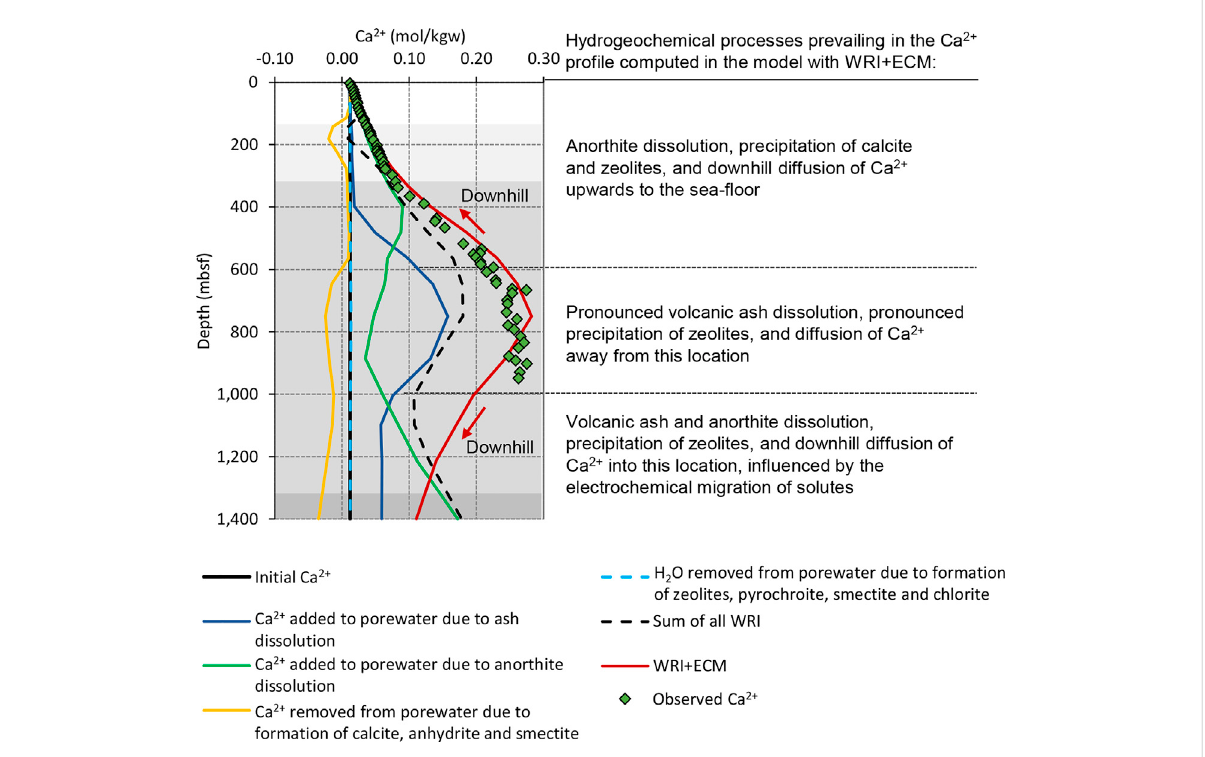
FIGURE 11 Identi fi cation of the hydrogeochemical processes prevailing in the different parts of the calcium pro fi le computed in the reaction-diffusion model that couples water-rock interactions to electrochemical migration of solutes (WRI+ECM). The graded grey background indicates the four lithological units shown in Figure